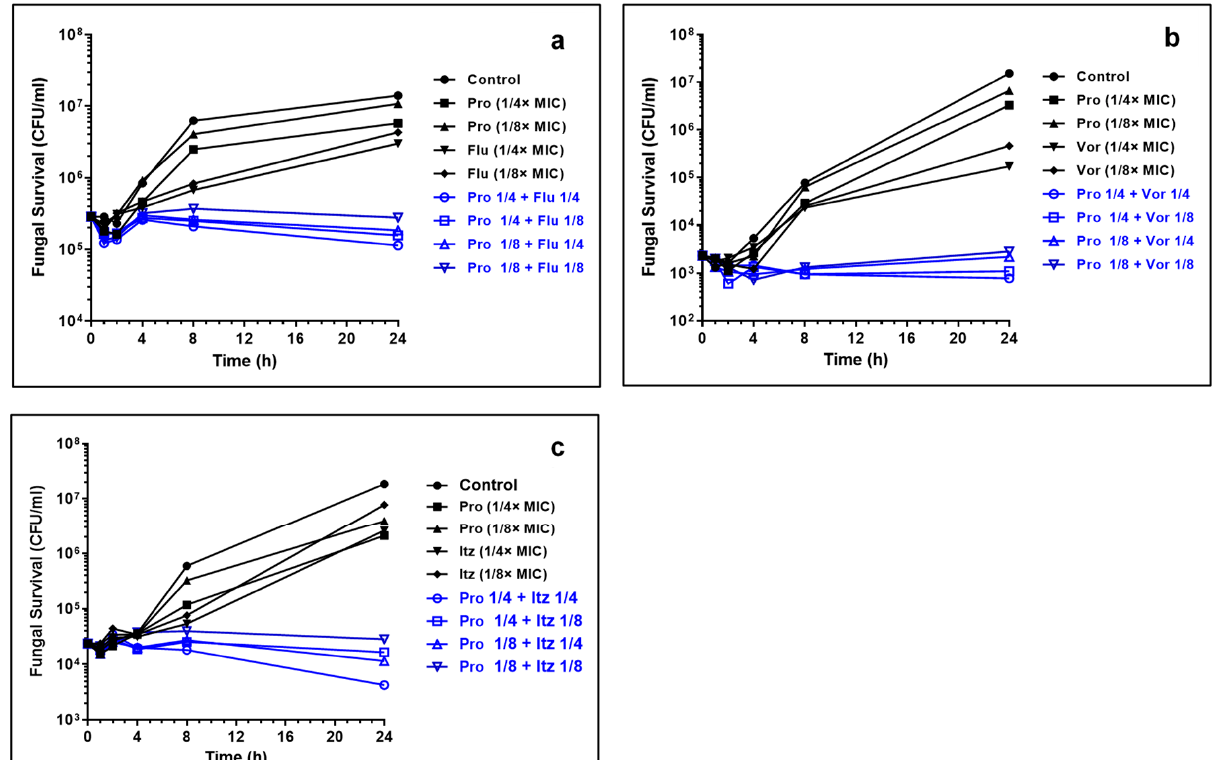
Figure 1. Time-kill kinetics of propranolol–azole combinations. ( a ) Propranolol (Pro) and fluconazole (Flu); ( b ) propranolol and voriconazole (Vor) and ( c ) propranolol and itraconazole (Itz).